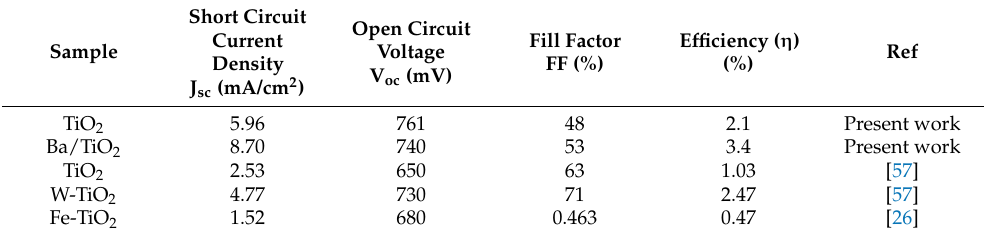
Table 3. Photovoltaic parameters derived from current voltage characteristic curves of synthesized TiO 2 and Ba/TiO 2 photoanodes.